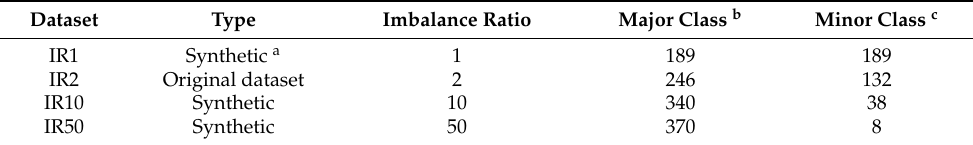
Table 3. Extent of the imbalance in the data sets used in this